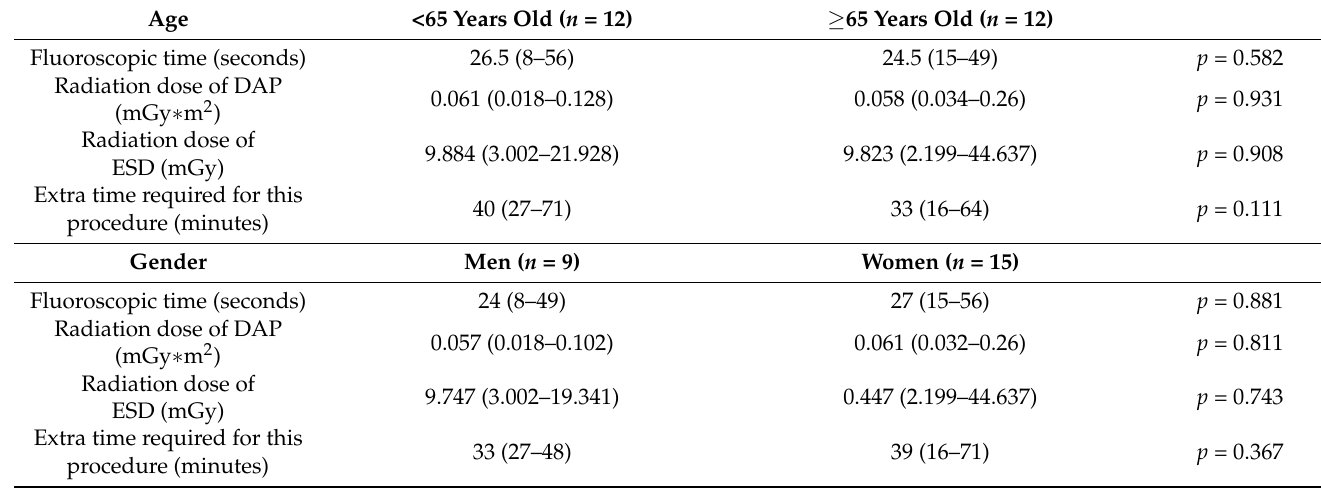
Table 3. Statistical examination of surgery and radiation data according to patient